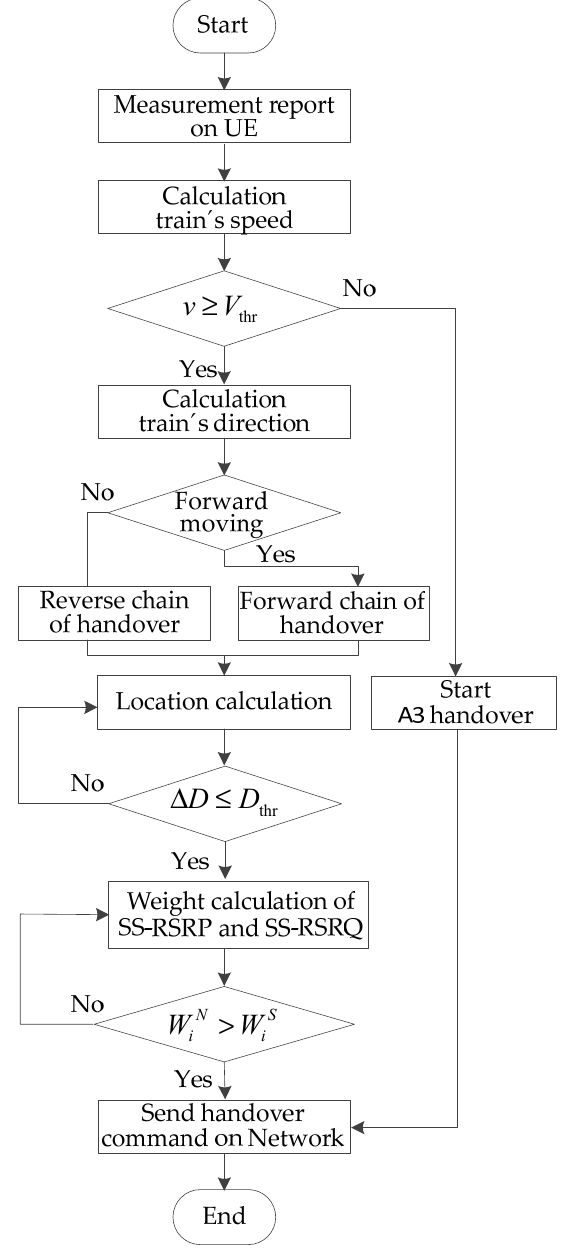
Figure 12. Flow chart of the fast handover algorithm.